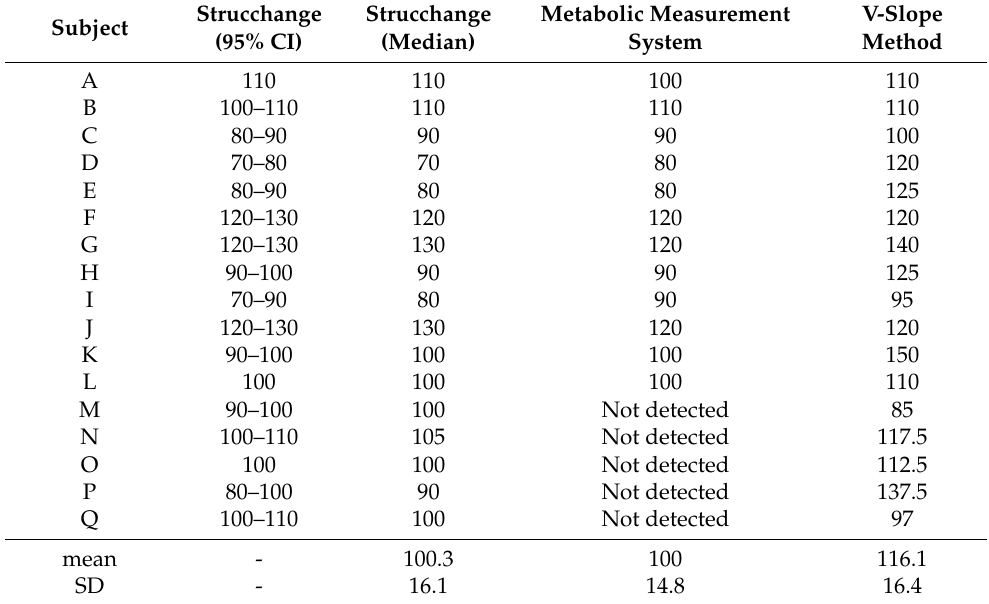
Figure 12. Typical examples of a V-slope without (( a ): left) and with (( b ): right) Rtshift. The shift of V-slope is judged relative to the R = 1 diagonal line [23]. Figure 12 was created based on subject data. Table 2. AT by strucchange, V-slope methods, and respiratory metabolic analysis in VE (numbers in table converted to W).